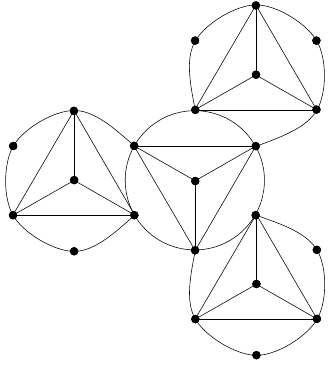
Fig. 5: A connected nontraceable LT graph with maximum vertex degree